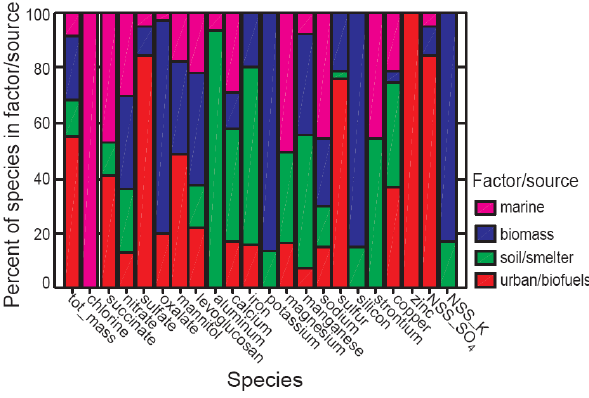
Figure 6 : PMF source profiles for the Paposo aerosols. 5 6 Fig. 6. PMF source profiles for the Paposo